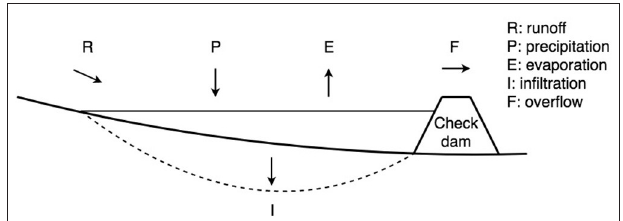
FIGURE 1 | Conceptual diagram of a check dam with impoundment showing the components of the water balance considered by the tool.